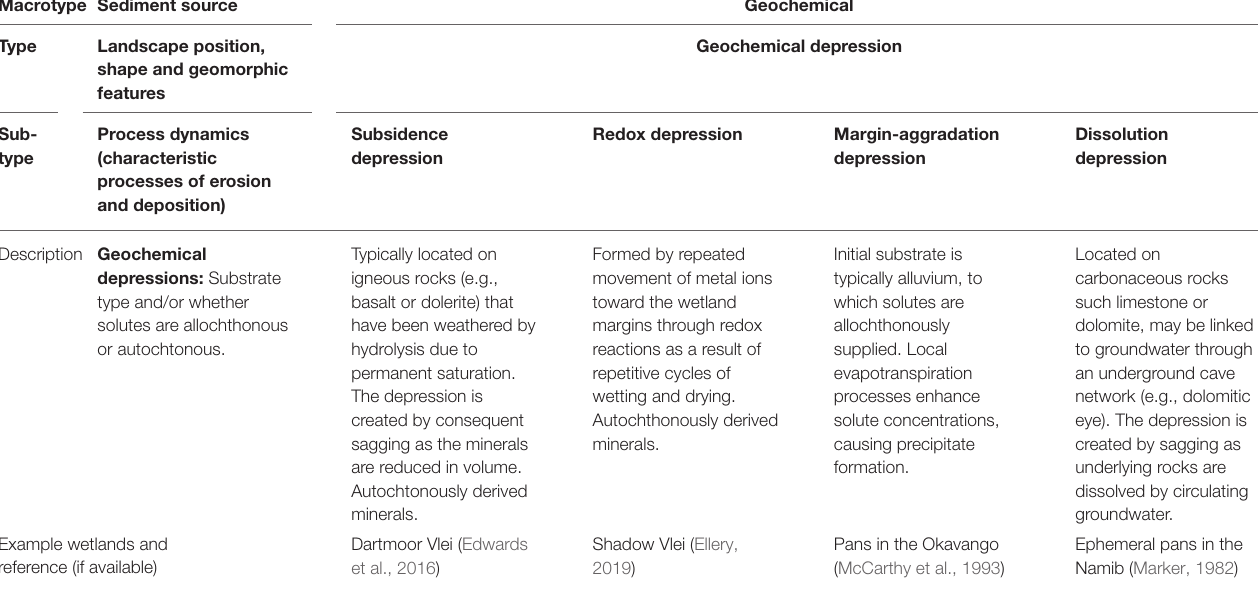
TABLE 5 | Geochemical depression